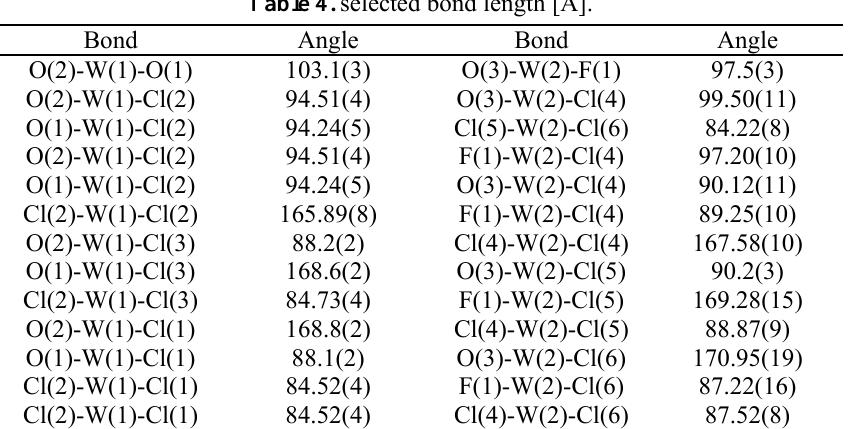
Table 4. selected bond length